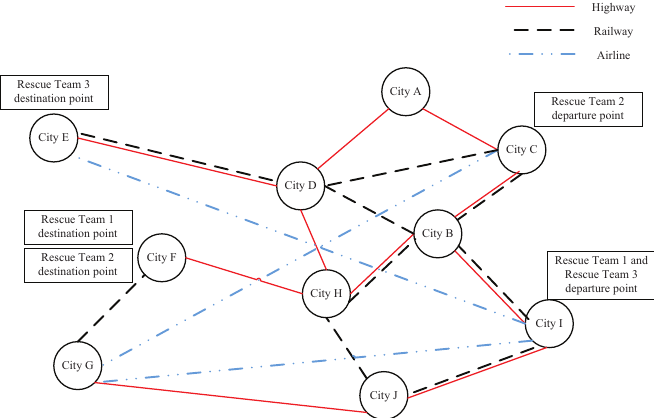
Figure 1. Illustration of the emergency logistics planning